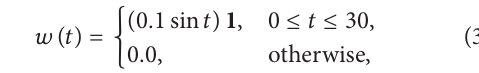
= 0.1 , we get from (19) that 𝛾 = 43.0731 . 2